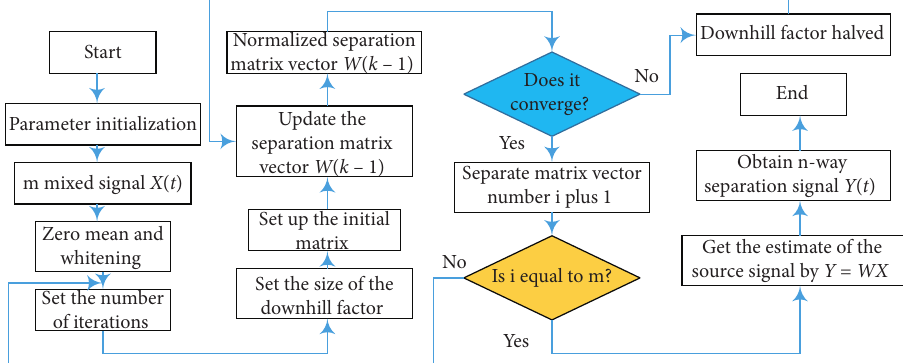
Figure 4: Algorithm flowchart.